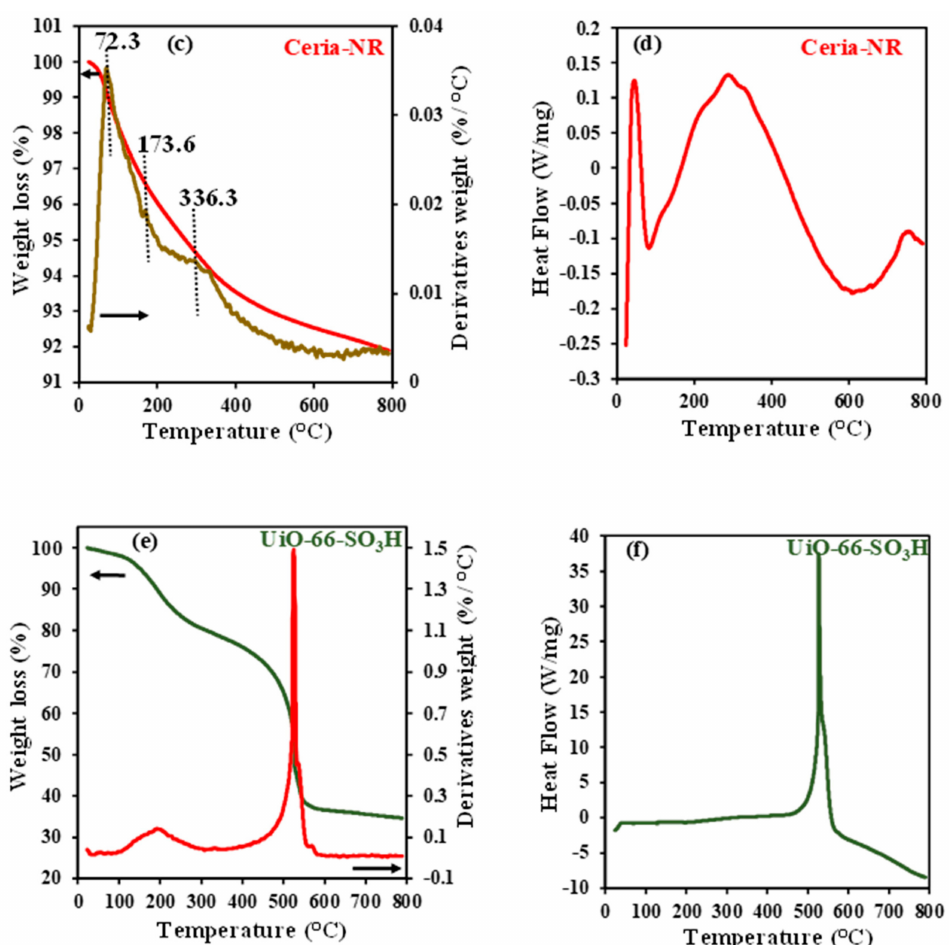
Figure 4. Weight loss ( a , c , d ) and heat flow ( b,e,f ) profiles during TGA-DTG analysis of Hopcalite ( a , b ), CeO 2 -NR ( c , d ) and UiO-66-SO 3 H ( e , f ).